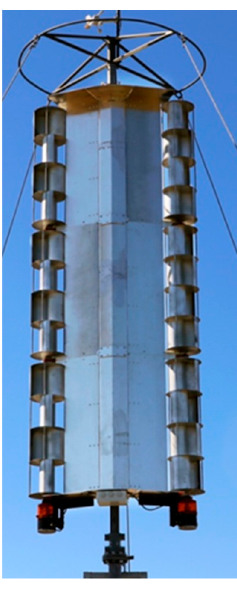
Figure 15. Prototype.